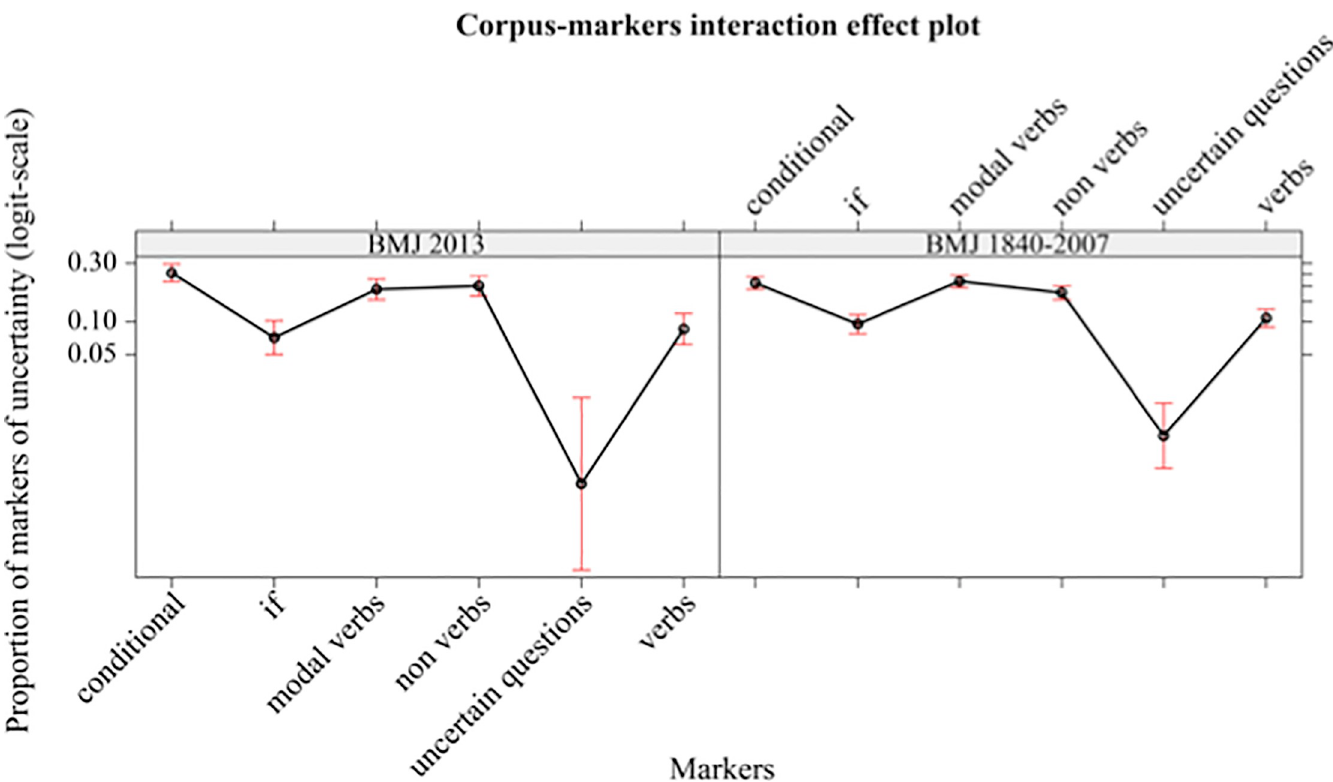
Fig 6. Mean proportions (95% confidence interval) of markers of uncertainty (in logit-scale) of different markers (conditional, if, modal verbs, non-verbs, uncertain questions, verbs), separately by corpus (BMJ 2013, BMJ 1840–2007 IMRaD articles).